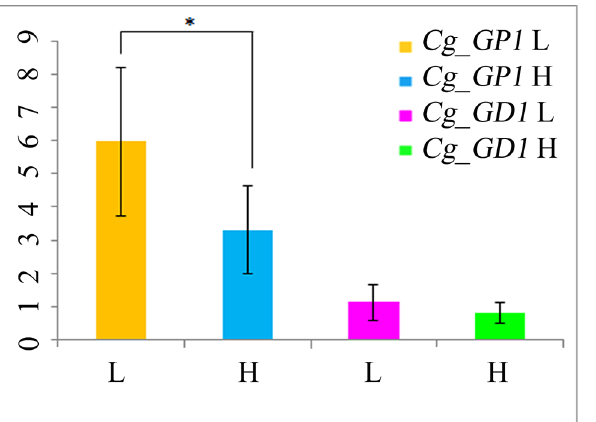
Fig 4. The mRNA expression levels of the high glycogen content and the low glycogen content groups. * P < 0.05, the difference between the high glycogen content and the low glycogen content group of Cg_GD1 was significant. Cg_GD1 , glycogen debranching enzyme encoding gene 1. Cg_GP1 , glycogen phosphorylase encoding gene 1.